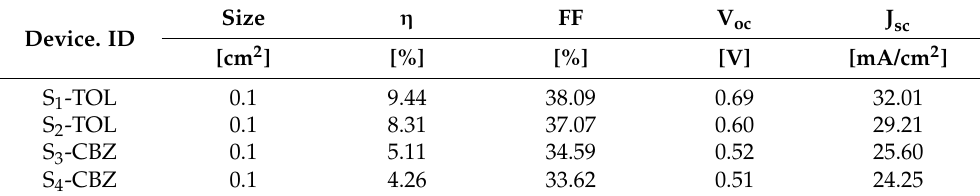
Table 5. Average performance of the Spiro-OMeTAD/MASnI 3 /C-TiO 2 /FTO devices . Device.ID